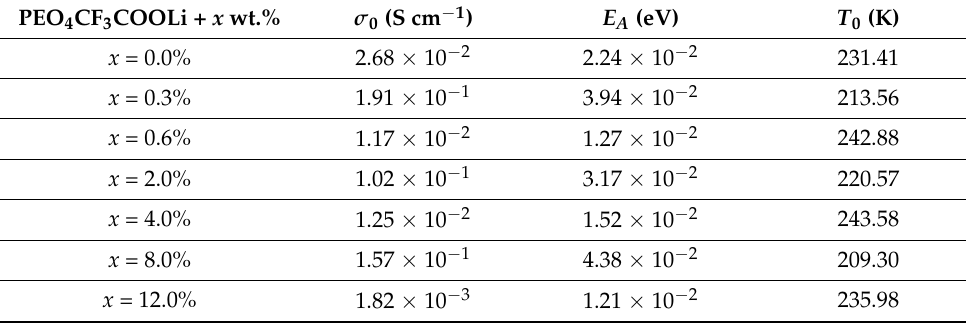
Table 6. Values for fitting of parameters in Equation